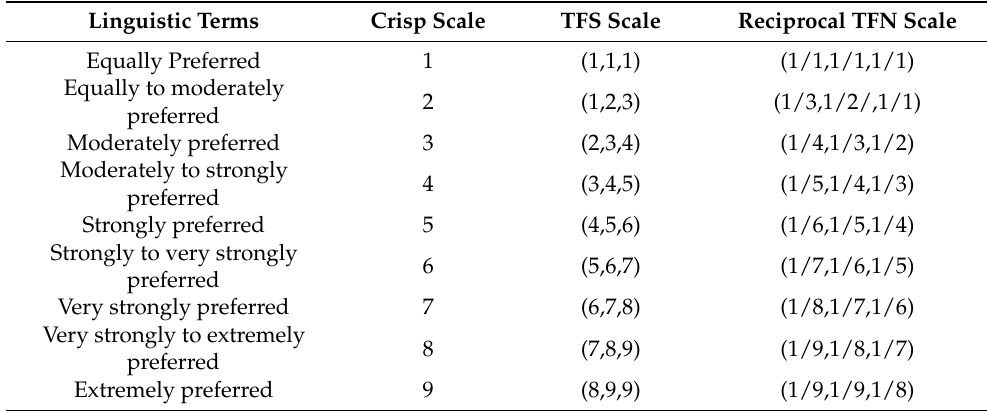
Table 2. Fuzzy conversion scale